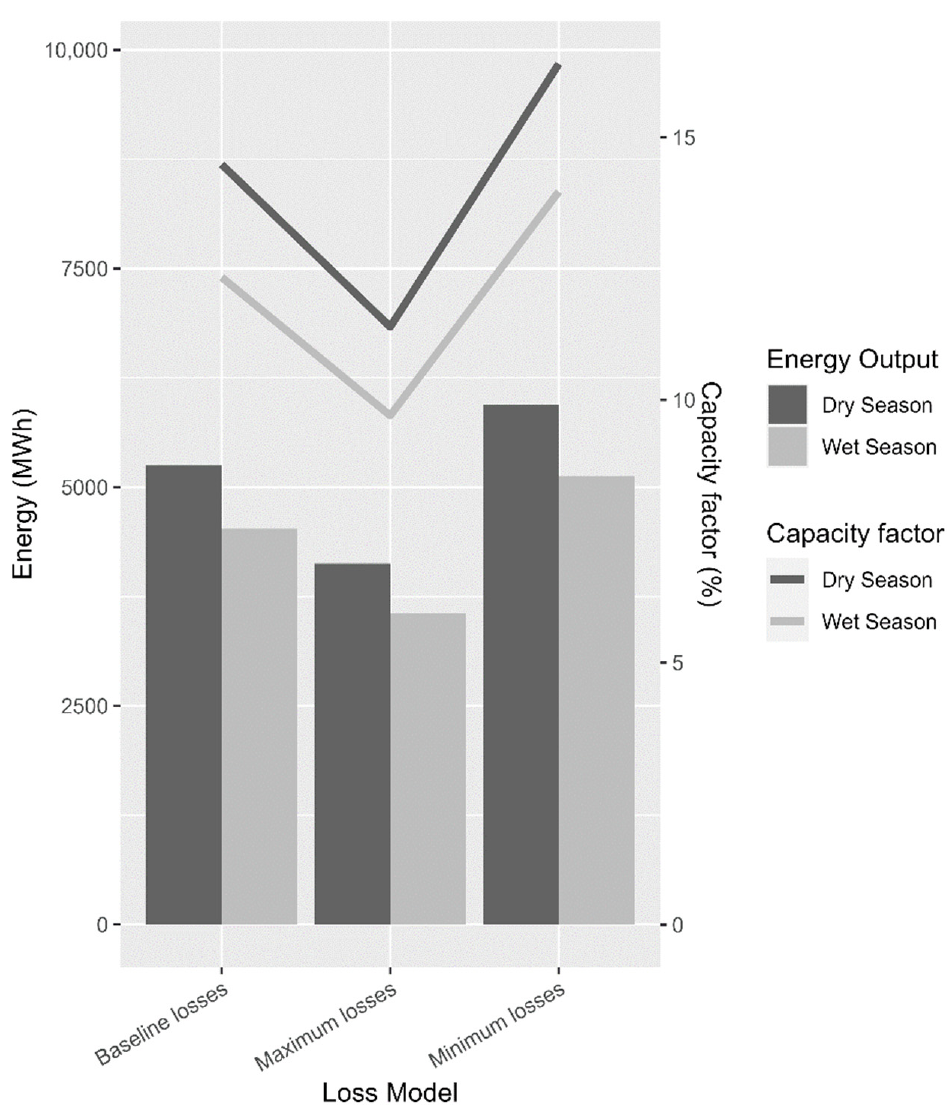
Figure 4. Energy output per month and CF estimates for each season using maximum, baseline and minimum loss models of the proposed prefeasibility tool.